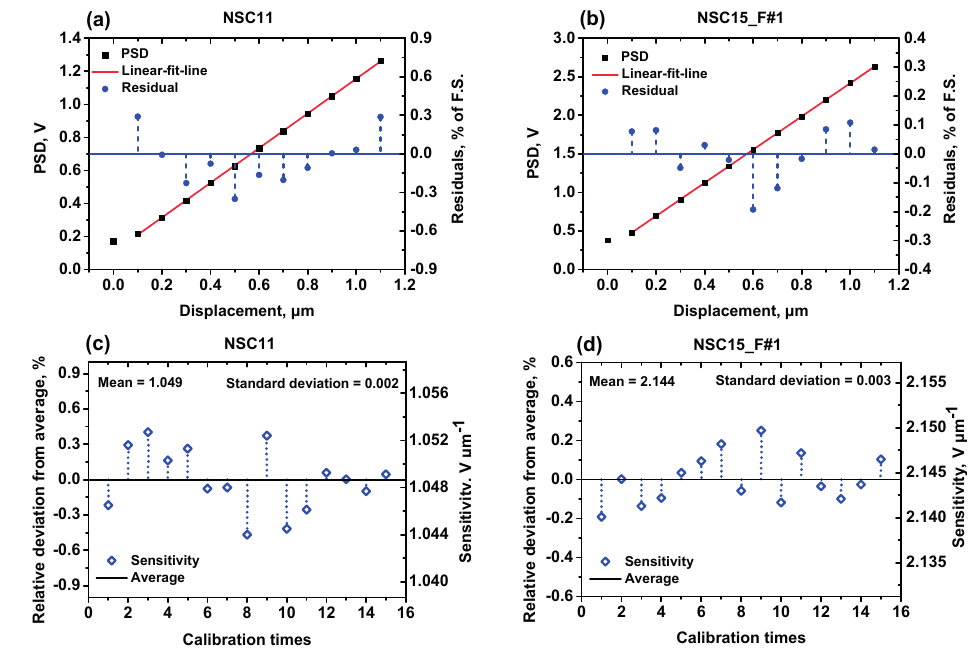
Figure 3. Optical lever sensitivity calibration curves of NSC11 and NSC15_F#1 cantilever. ( a , b ) are the voltage-displacement relationships; ( c , d ) are the scatters of the optical lever sensitivity obtained from 15